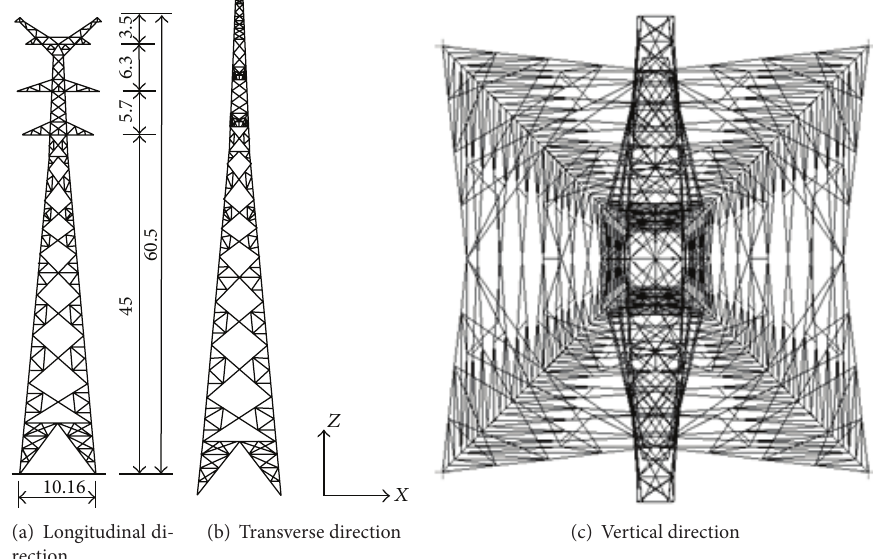
Figure 1: Longitudinal, transverse, and vertical views of a transmission tower (m).